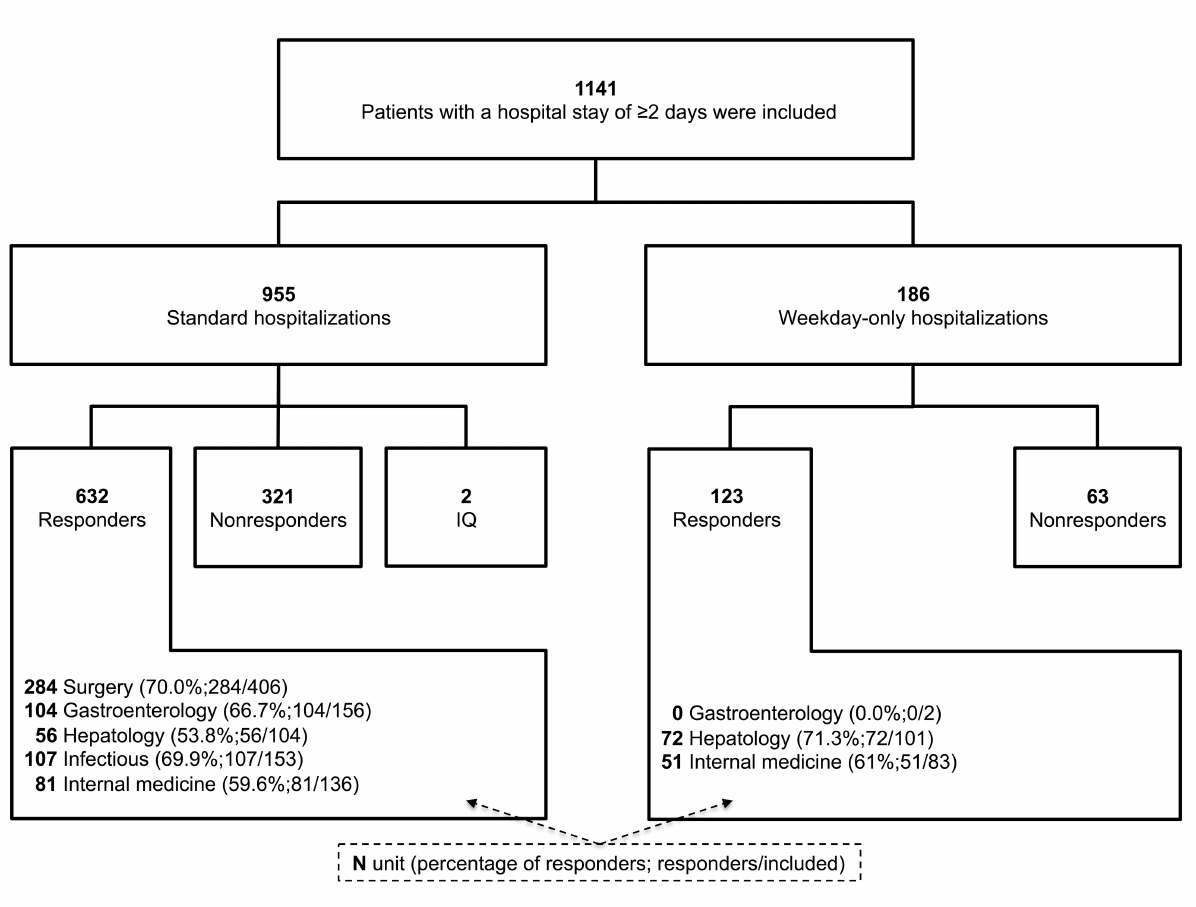
Figure 1. Flowchart of patients with a hospital stay of ≥ 2 days included in the SENTIPAT trial who responded or not to the discharge questionnaire according to the type of hospitalization and the recruitment unit. IQ: incomplete questionnaires; surgery: general and digestive surgery; infectious: infectious and tropical